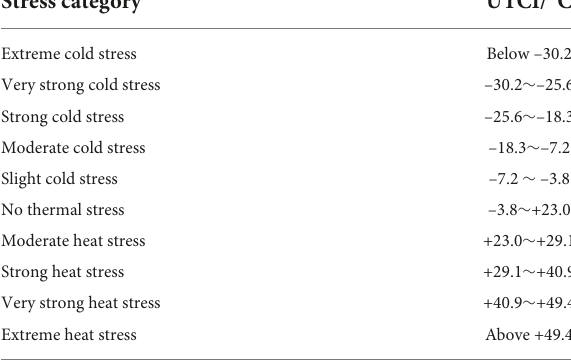
TABLE 2 The revised Harbin universal thermal climate index (UTCI) thermal stress